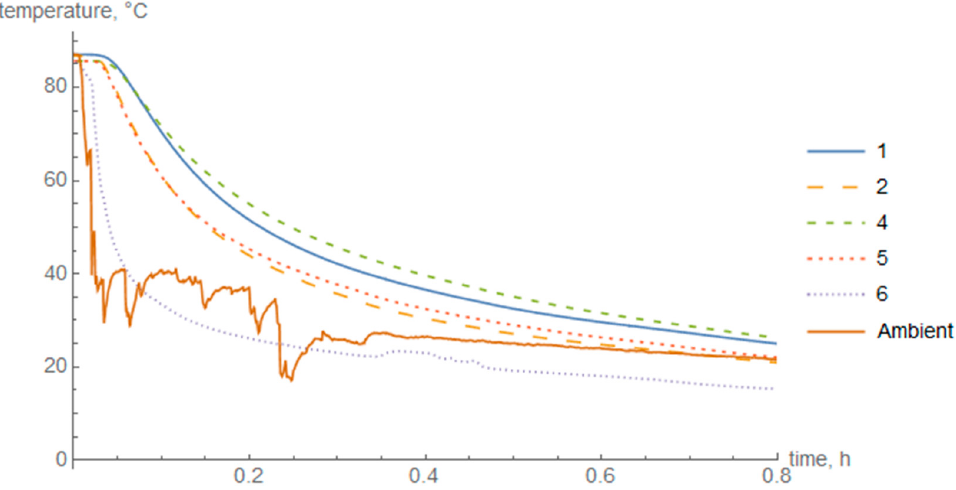
Figure 10. Temperature change in individual layers during cooling in water.